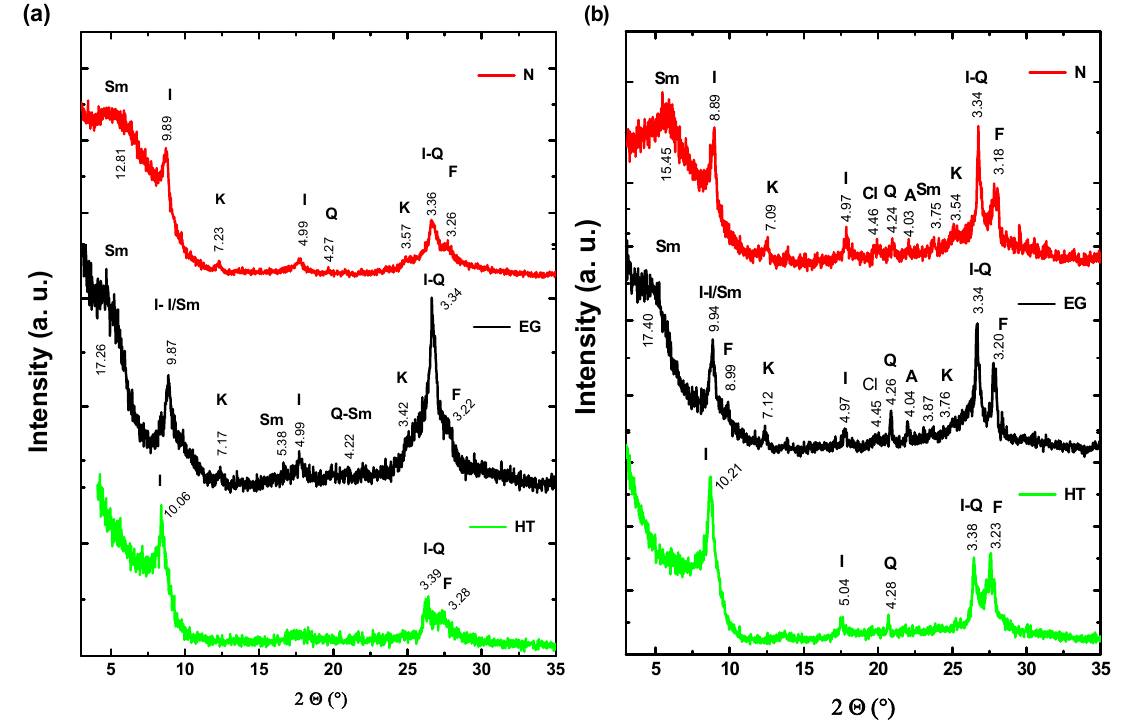
Figure 5. Diffractograms from the clay fractions (<2 μm) of ( a ) DR1 (0–5 cm) and ( b ) SF6 (25–30 cm). XRD patterns shown were obtained after the samples were air-dried (N), ethylene-glycol-solvated (EG), or heat-treated at 550 °C (HT). The main compounds identified are marked as Q (quartz), I (illite), Sm (smectite), K (kaolinite), A (albite), Cl (clay minerals), and F (feldspar).